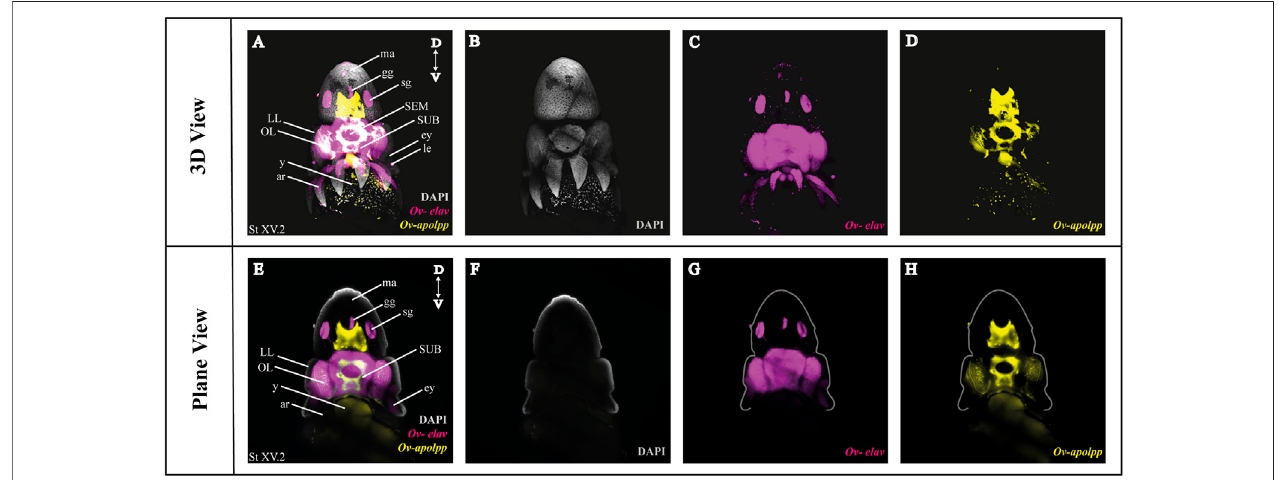
FIGURE3| WholeMountHCRv3.0followedbyfructose-glycerolclearingonan Octopusvulgaris embryo(developmentalstageXV)imagedwithLSFM.Toppanel illustrates the merged 3D view from the posterior side of the embryo, and bottom panel shows a single plane of a coronal section. (A) Overview image showing the expression of Ov-elavand Ov-apolpp on aStage XV embryo in 3D. Note thatonly high-level expression isretainedonthe merged view. DAPI(in grey) isused fornuclear labelling. (B – D) 3 individual channels from (A) . (E) Overview image showing the expression of Ov-elav and Ov-apolpp on a coronal section of Stage XV embryo. (F – H) 3individualchannelsfrom (E) . Abbreviations:ar,arm;D,dorsal;ey,eye;fu,funnel;gg,gastricganglion;LL,laterallip;ma,mantle;n,neuropil;OL,opticlobe;SEM, supraesophageal mass; sg, stellate ganglion;SUB, subesophageal mass; V, ventral; y, yolk.